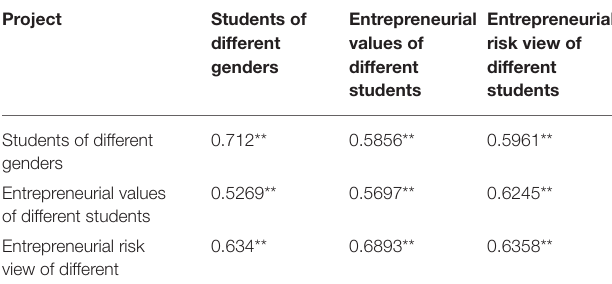
TABLE 3 | Correlation test results between different variables.